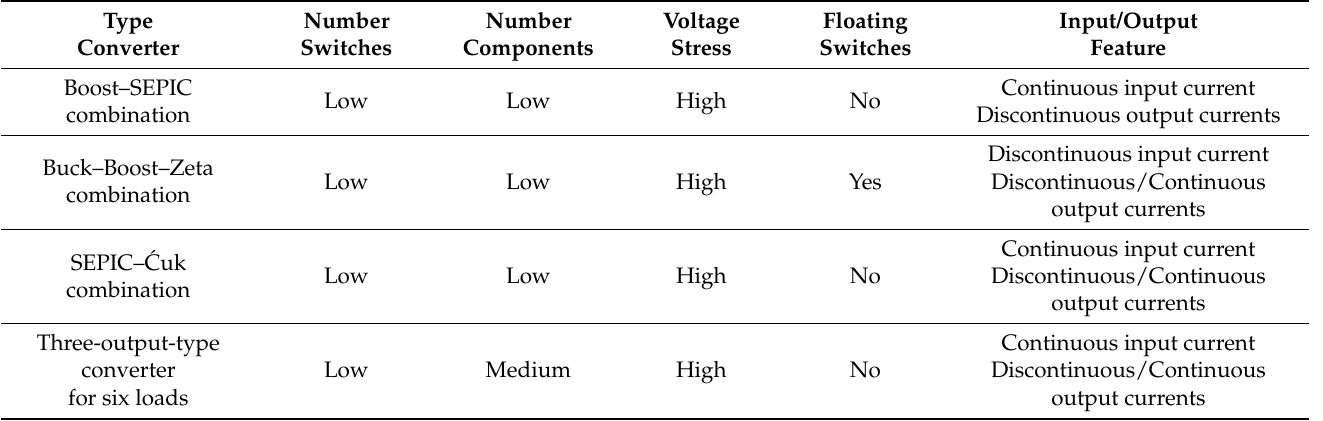
Figure 10. Three-output-type converter combination for six loads.